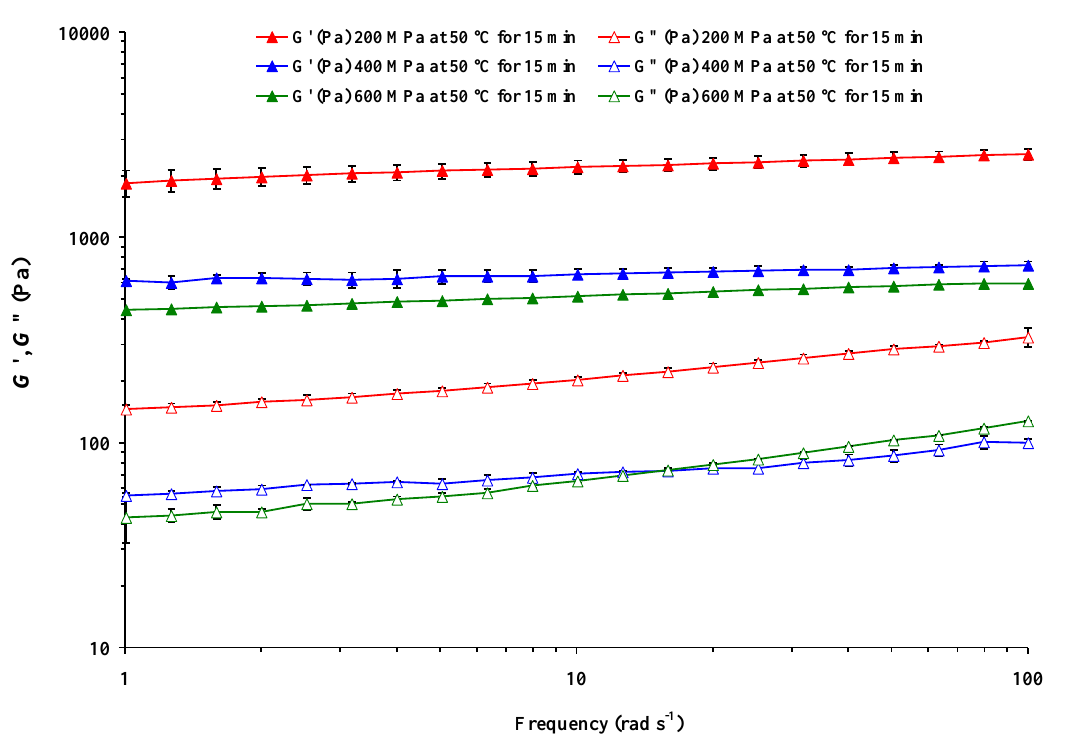
Figure 2. Effect of pressure on mechanical spectra of heat-induced chickpea flour gel pressurized (15 min at 50 °C) at 25 °C. Mean values of six measurements ± error